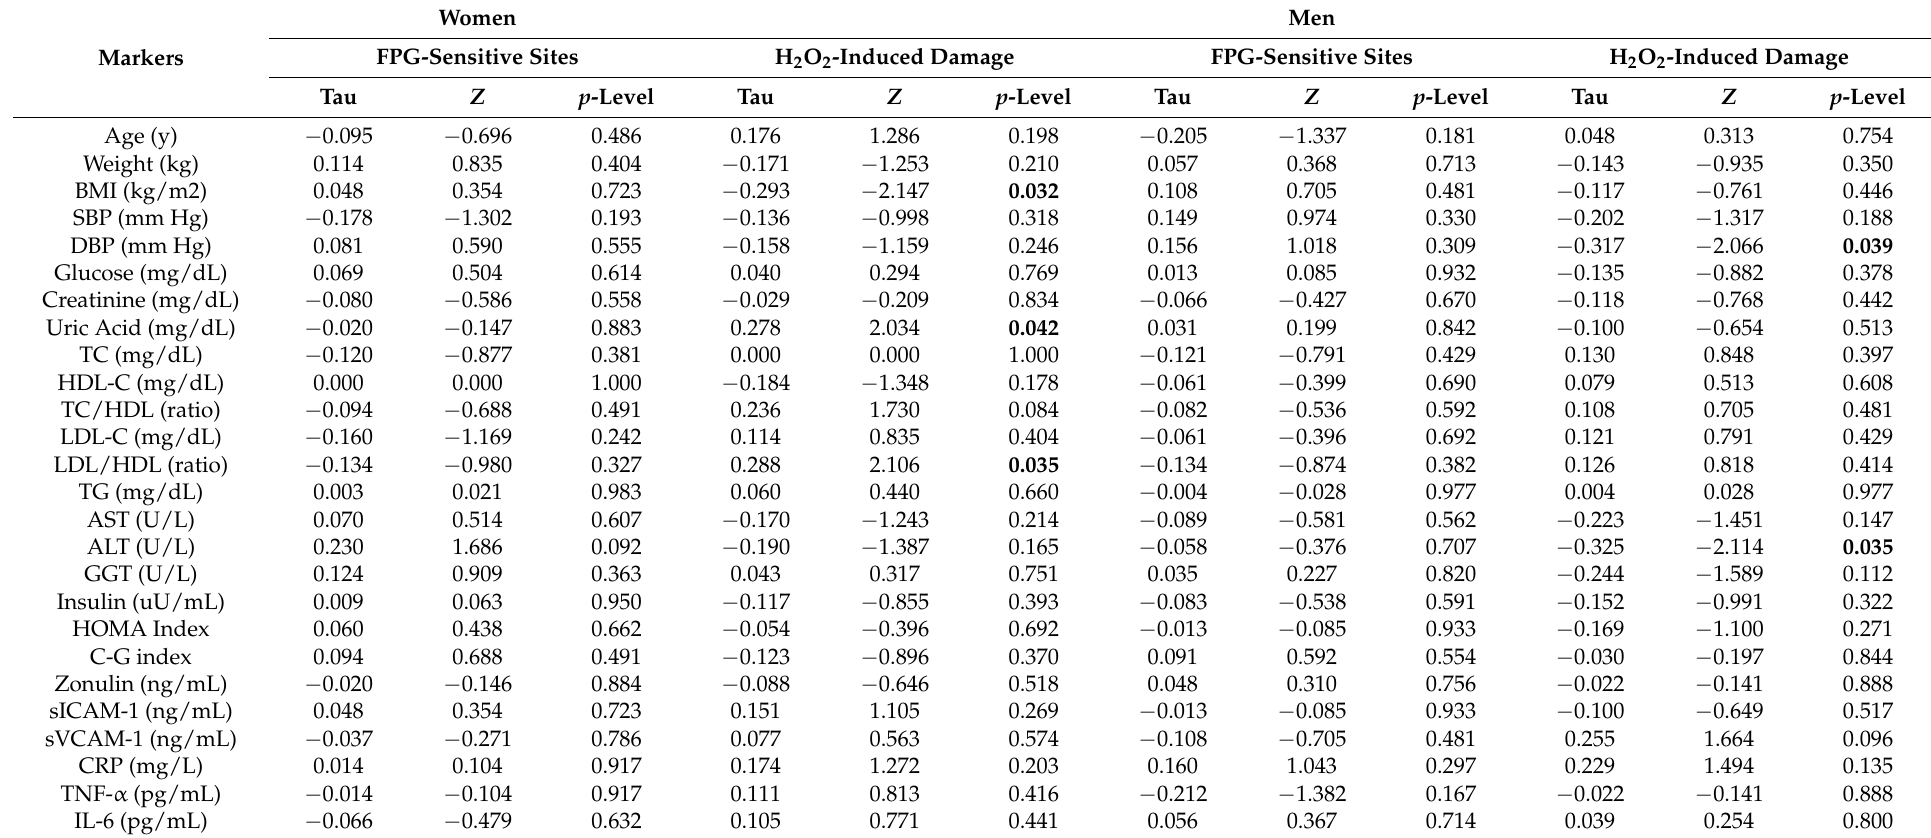
Table 5. Correlation analysis between anthropometric, metabolic and clinical markers and DNA damage in women and